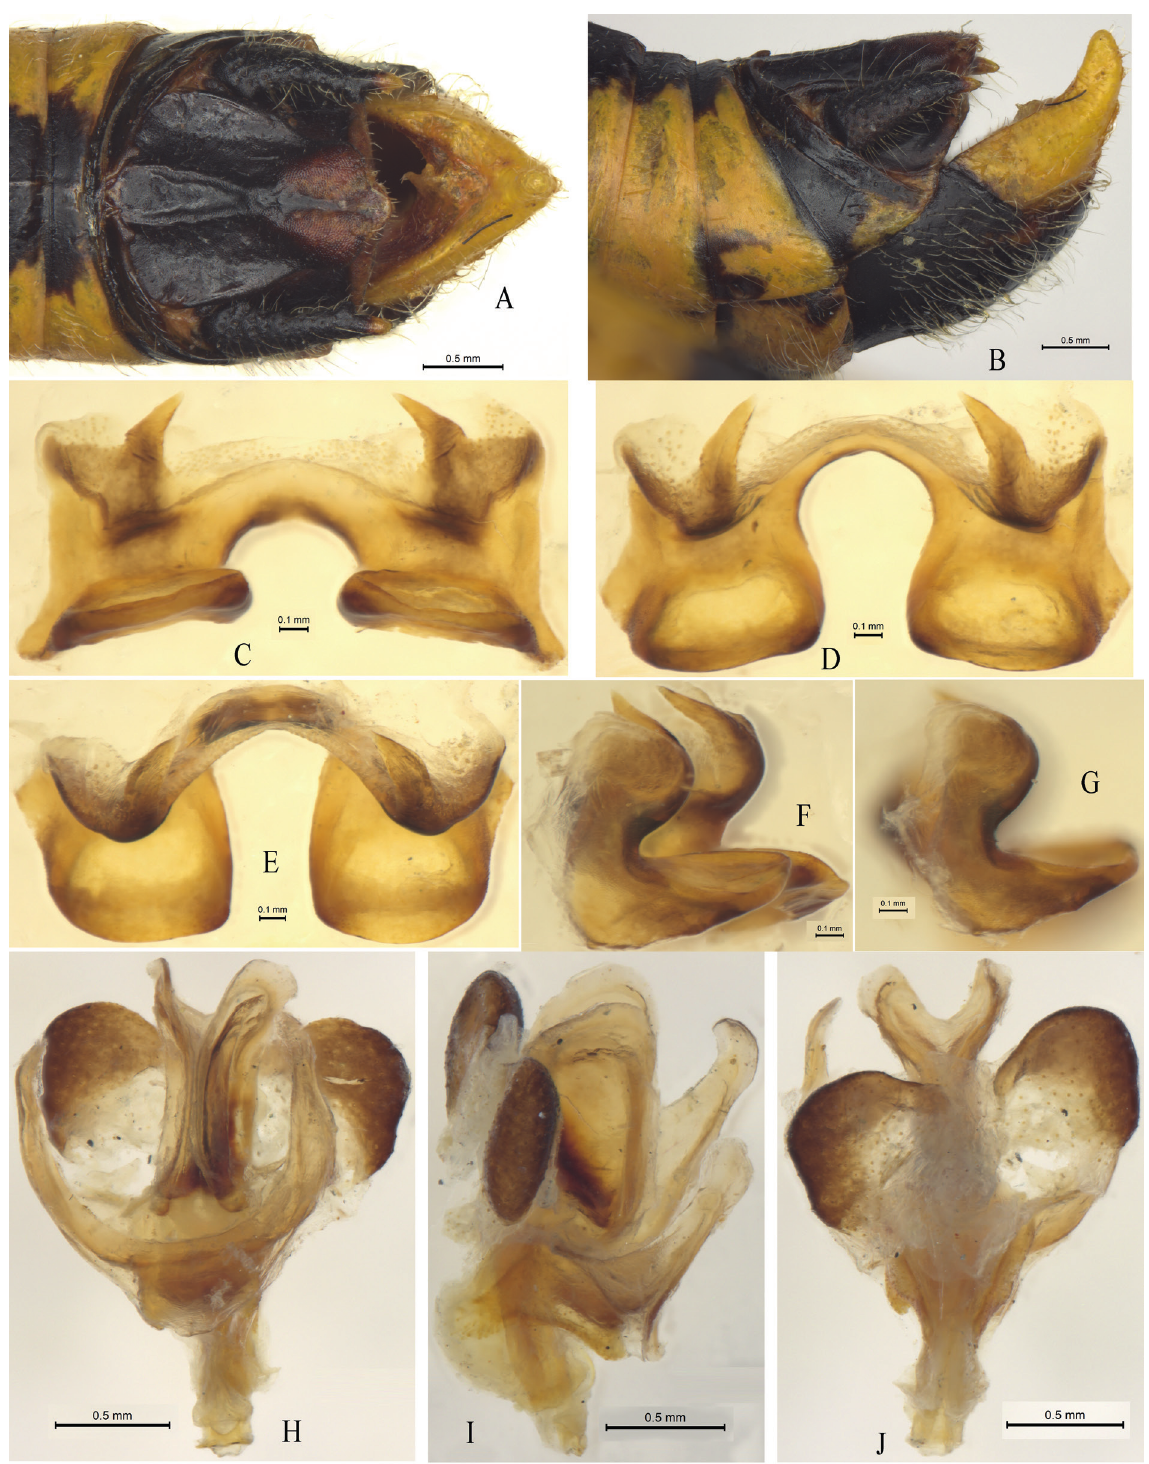
Fig. 4. ♂ (DU) of Bannacris punctonotus Zheng, 1980 syn. nov. (= Pseudotraulia cornuata Laosinchai & Jago, 1980). A–B . Abdominal apex in dorsal and lateral views. C–G . Epiphallus in dorsal, dorsofrontal, frontal, dorsolateral and lateral views. H–J . Phallic complex in dorsal, lateral and ventral